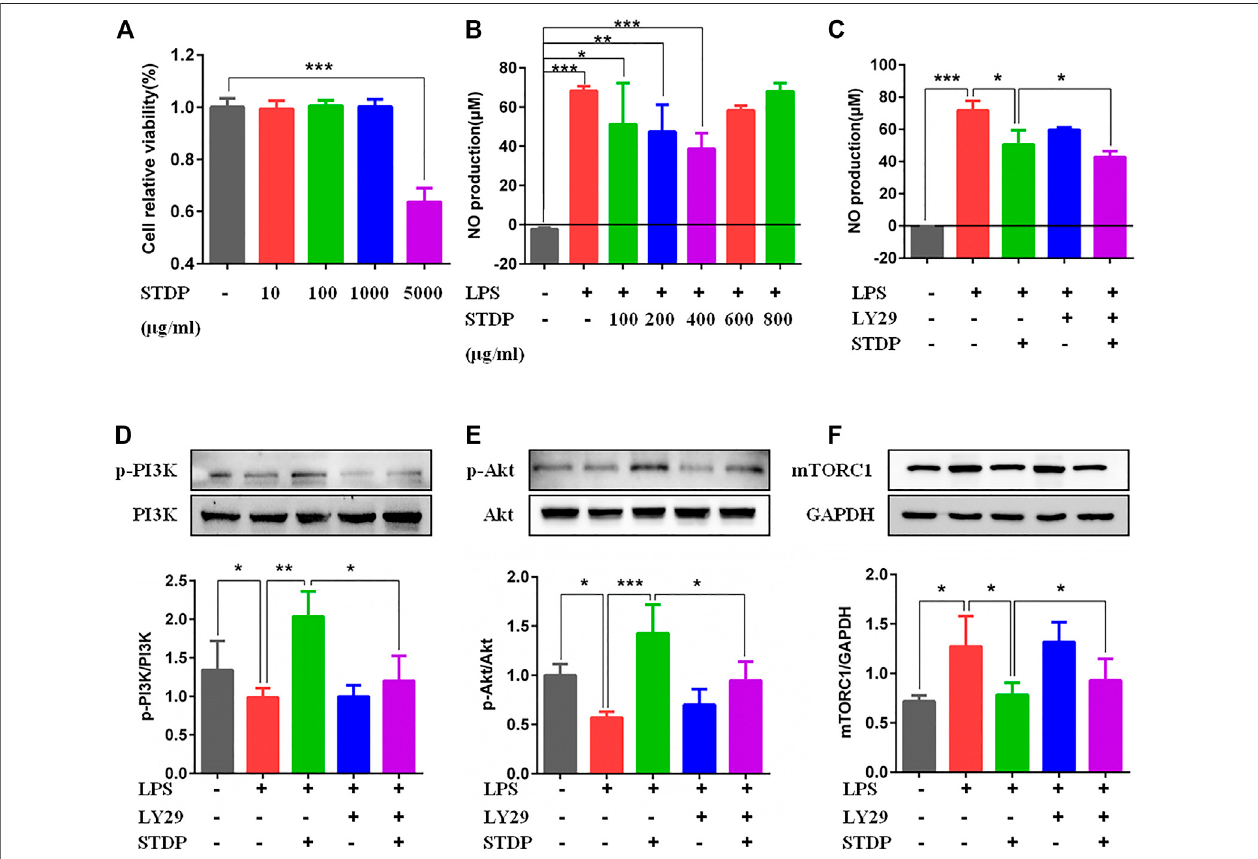
FIGURE5| STDPsregulatedthePI3K/AKT/mTORC1pathwayinBMDMs. (A) STDPs(10,100,and1,000 μ g/ml)hadnocytotoxicityonBMDMs. N = 6pergroup. (B, C) NO level in the cell supernatant in the different groups. N = 6 per group. (D – F) Representative immunoblots and analysis for p-PI3K, p -Akt, and mTOCR1 in the control, model, STDP, LY29, and LY29+STDP groups. N = 3 per group. * p < 0.05, ** p < 0.01, *** p < 0.001.